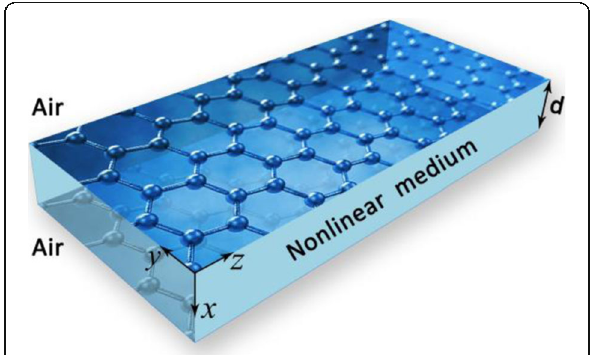
Fig. 1 Schematic diagram of nonlinear graphene-dielectric-graphene plasmonic